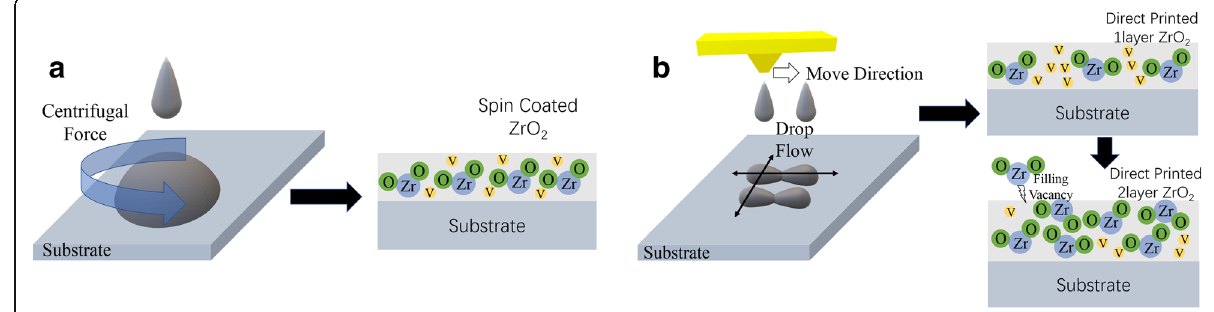
Fig. 1 Film formation process of a spin coating and b direct inkjet printing